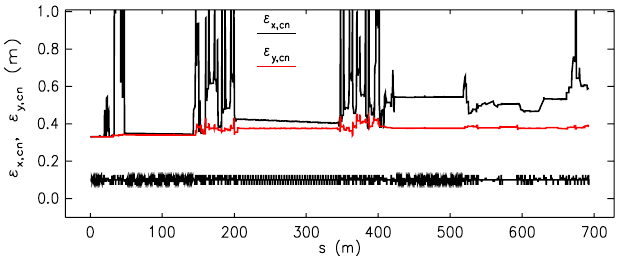
FIG. 14. Normalized emittances (less dispersive contributions) through recirculating linac to the entrance of the FEL.